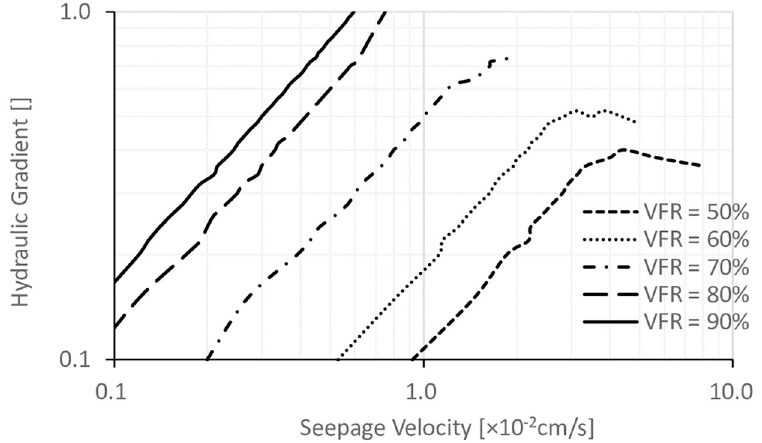
Fig 9. The relationship between the hydraulic gradient and the seepage velocity for specimens with different VFR values and D c =